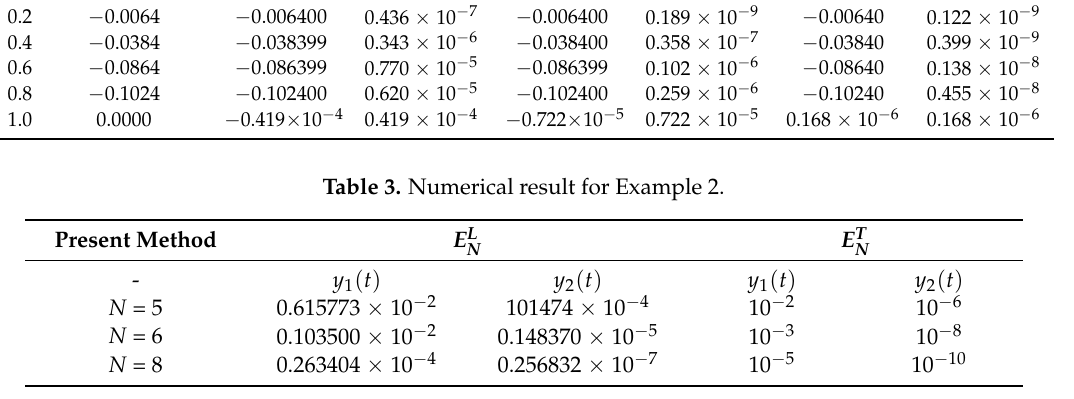
Figure 2. Comparison of absolute errors function for